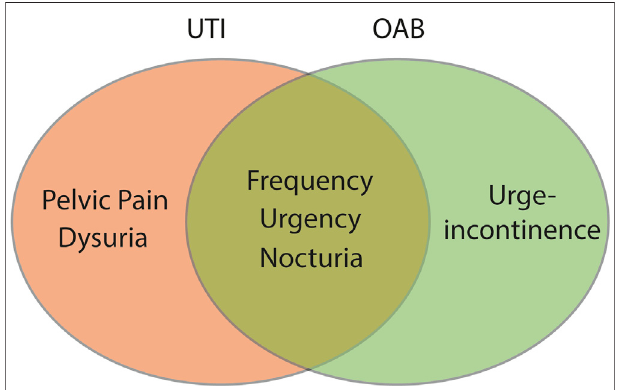
FIGURE 1 | The primary symptoms of OAB and UTI overlap. Urinary frequency, urinary urgency, and nocturia are key symptoms associated with bothOABandacuteUTI.Clinically,OABisdifferentiatedfromacuteUTIbythe absence of bacteriuria and/or a negative dip-stick test.